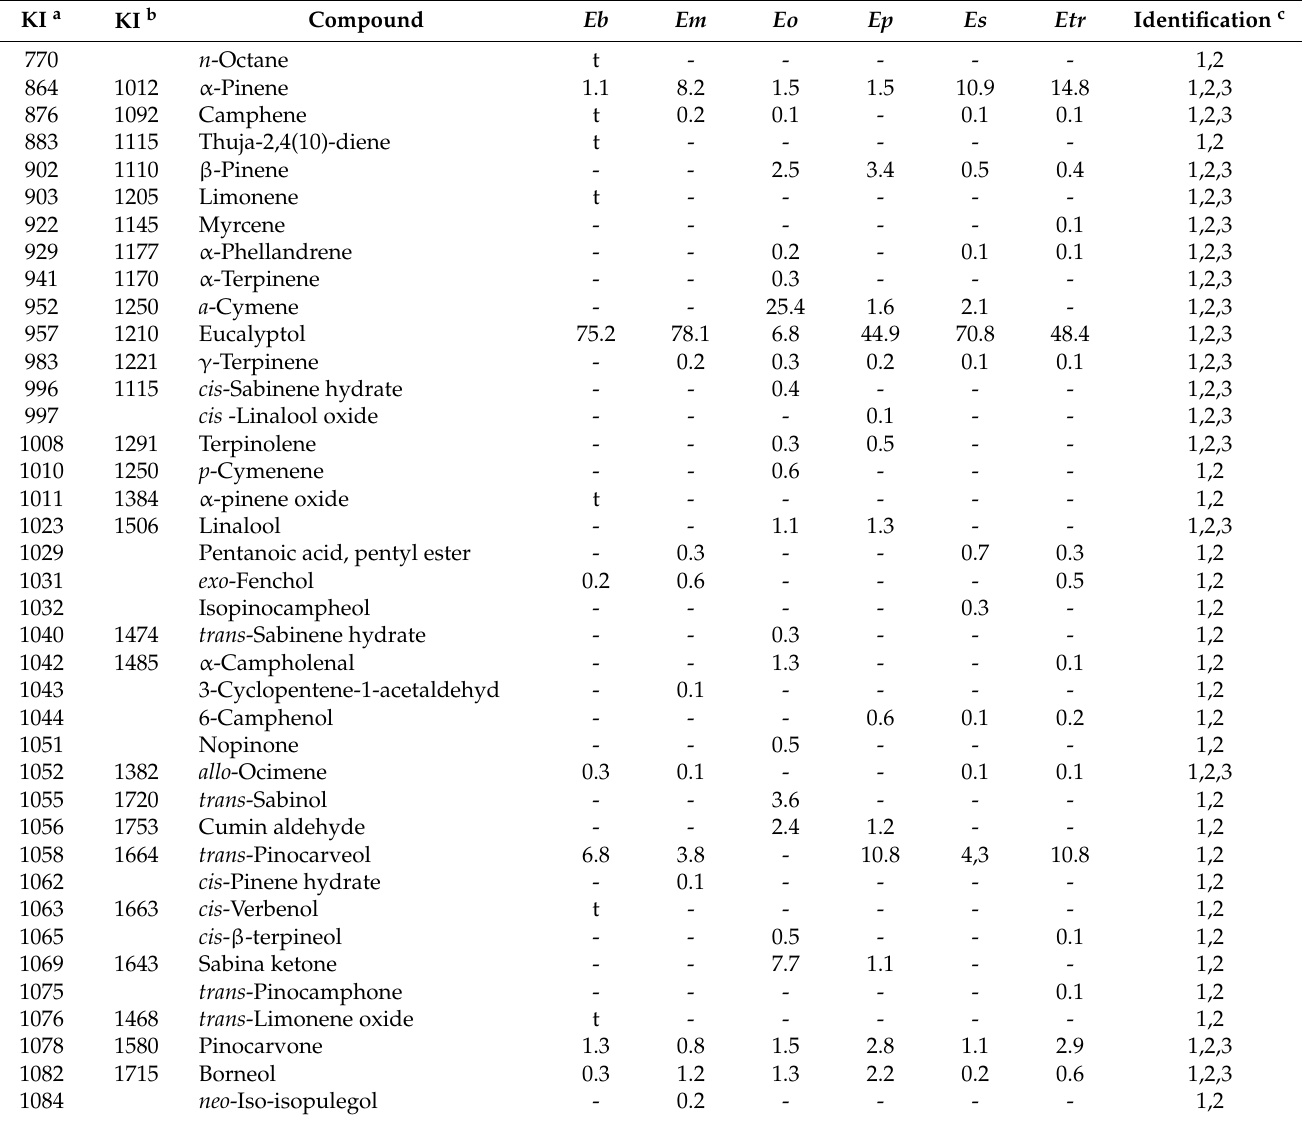
Table 1. Chemical composition of the EOs of Eucalyptus bosistoana ( Eb ), E. melliodora ( Em ), E.